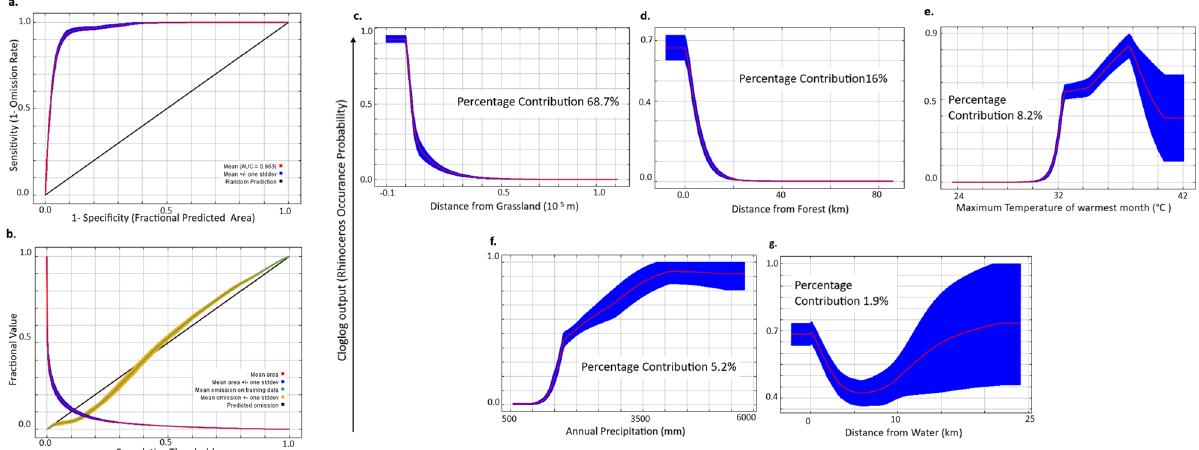
Figure 1. ( a ) Receiver operator curve for assessing model fit, ( b ) Omission/Commission analysis for model accuracy of classifying test data. Species occurrence probability (response curves) obtained from 100 bootstrap runs of the best model explaining the distribution of greater one horned rhinoceros in Maxent to ( c ) distance to grassland, ( d ) distance to forest, ( e ) maximum temperature of warmest month, ( f ) annual precipitation, and ( g ) distance to